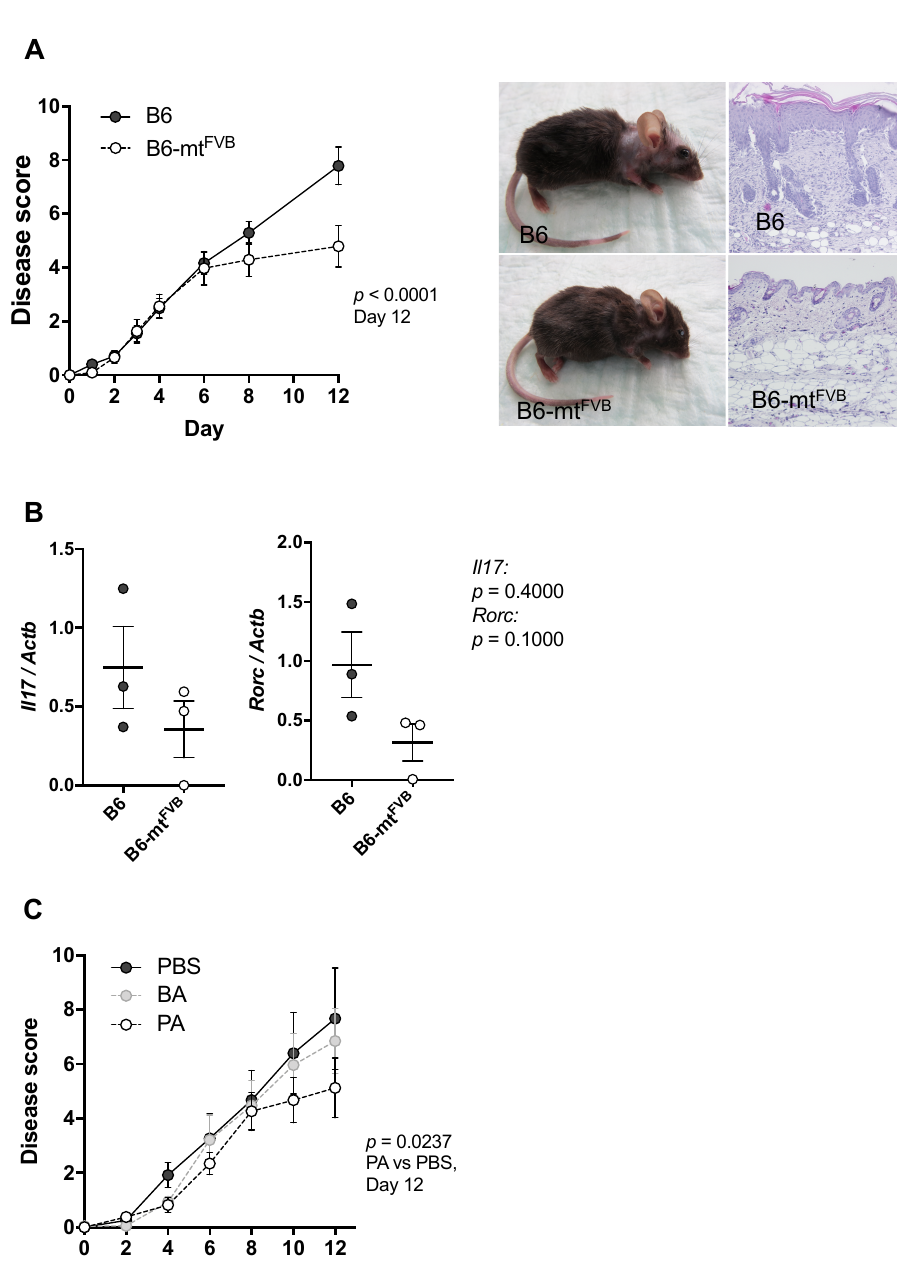
Figure 4. The natural variation, m.7778G > T in the mt-Atp8 gene resulted in significantly milder disease severity in experimental skin inflammation model, and supplementation of propionic acids mimic the effect of the mutation in diseased mice. ( A ) Experimental autoimmune skin disease was induced in B6-mt FVB and B6 mice by repetitive injection of pathogenic immunoglobulins G (IgG) (i.e., rabbit IgG against murine type VII collagen). Left: Disease score at day 12 in B6-mt FVB mice were significantly less than that in B6 mice. p < 0.0001, two-way ANOVA. Right: Representative pictures of clinical phenotype and skin histopathology in B6 (top) and a B6-mt FVB (bottom) mice at day 12. N = 20 (B6-mt FVB ) and 17 (B6), male. ( B ) Relative expression of IL-17 and ROR γ T genes ( Il17 and Rorc , respectively) to housekeeping gene (beta-actin; Actb ) was evaluated in neck skin samples obtained from pathogenic IgG-injected B6 and B6-mt FVB mice at day 12 by qPCR. p = 0.4000 ( Il17 ), p = 0.1000 ( Rorc ), Mann–Whitney U test, n = 3/strain. ( C ) Short chain fatty acids, propionic acid (PA) and butyric acid (BA), were administrated in addition to the pathogenic IgG injections in B6 mice. Mice in the control group were received PBS. Disease score in mice injected with PA exhibited significantly less than that in control mice. p = 0.0237, two-way ANOVA. N = 8 (PA) or 9 (BA and PBS). Male, 3 to 4 months